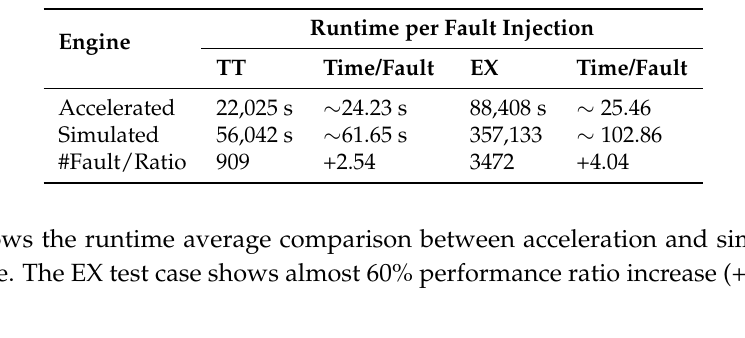
Table 8. Runtime average per fault run when targeting the EX unit.